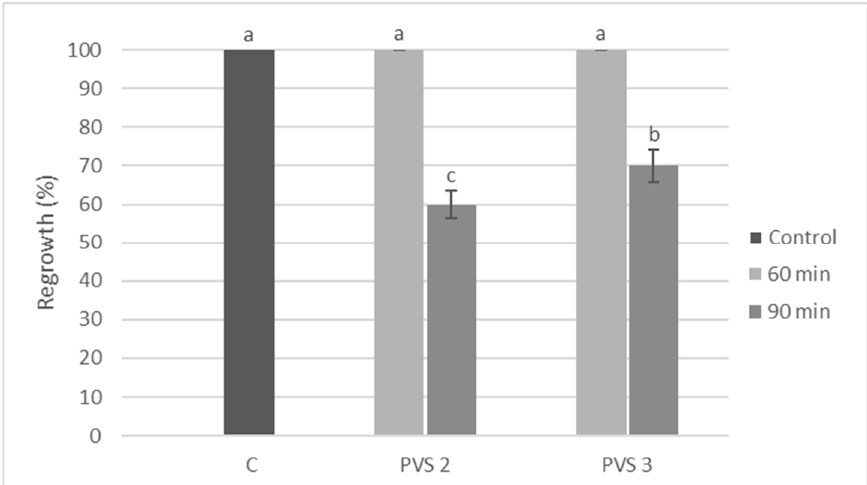
Figure 2. Effect of vitrification solutions (PVS2 or PVS3), applied for 60 or 90 min, on regrowth (%) of axillary buds of Corylus avellana , cultivated variety Tonda Gentile Romana, not immersed in liquid nitrogen. Control (C) indicates explants directly transferred to the recovery solution after loading phase. Error bars indicate SE. Bars marked with the same letter are not significantly different according to Tukey’s test ( p ≤ 0.05).